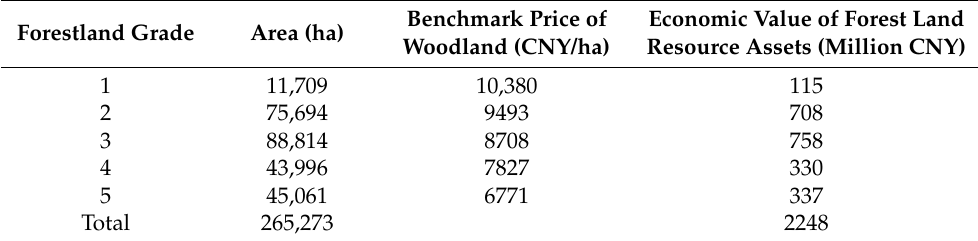
Table 6. Accounting table of economic value of forest land resource assets in Longquan County. Benchmark Price Forestland Grade Area (ha)